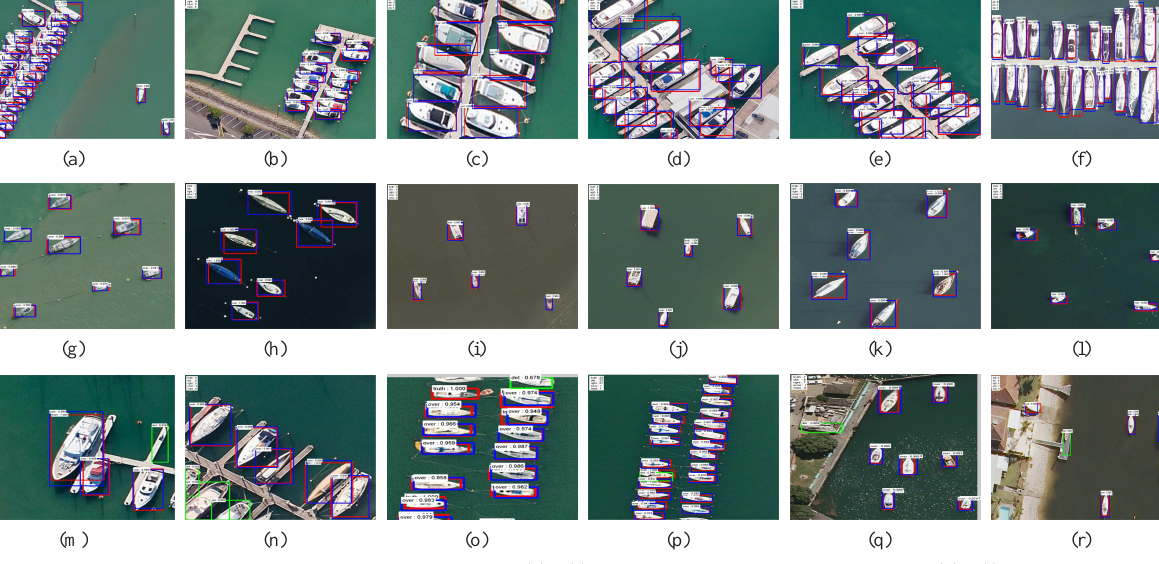
Figure 9: The results of our proposed ship detection system. (a) - (f) are inshore ship detection results, and (g) - (l) show some offshore ship detection results. (m) - (r) are special selection results which have error or lack